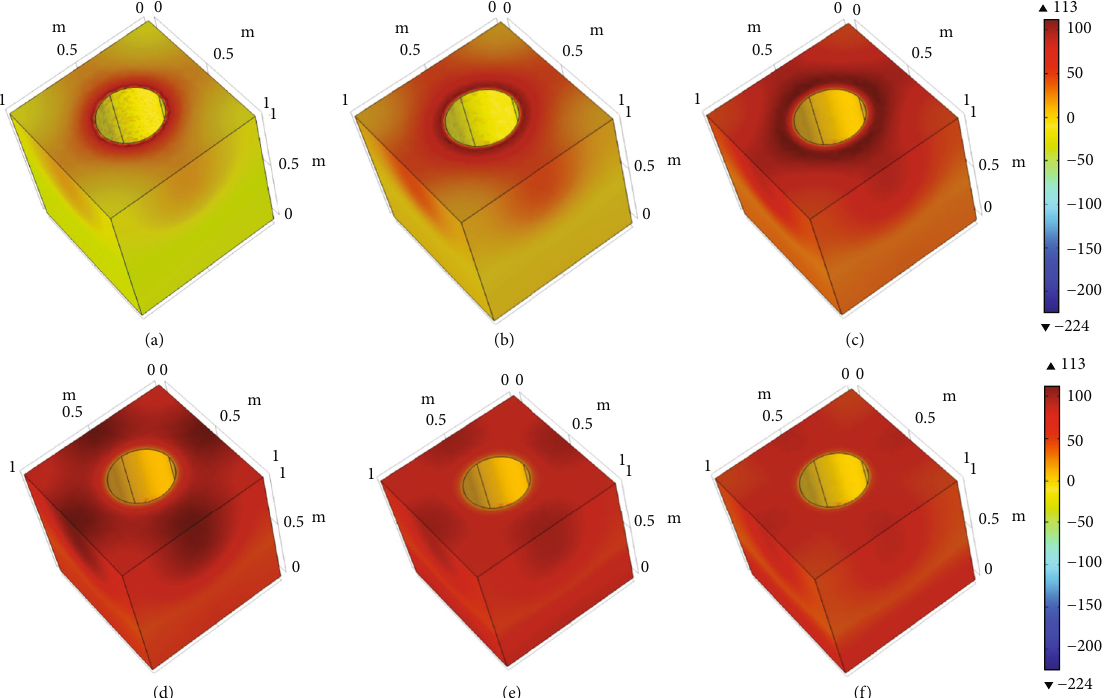
Figure 4: First principal stress fi eld in the homogeneous coal rock: (a) t = 0 : 1 s, (b) t = 1 × 10 3 s, (c) t = 1 × 10 4 s, (d) t = 1 × 10 5 s, (e) t = 1 × 10 6 s, and (f) t = 1 × 10 7